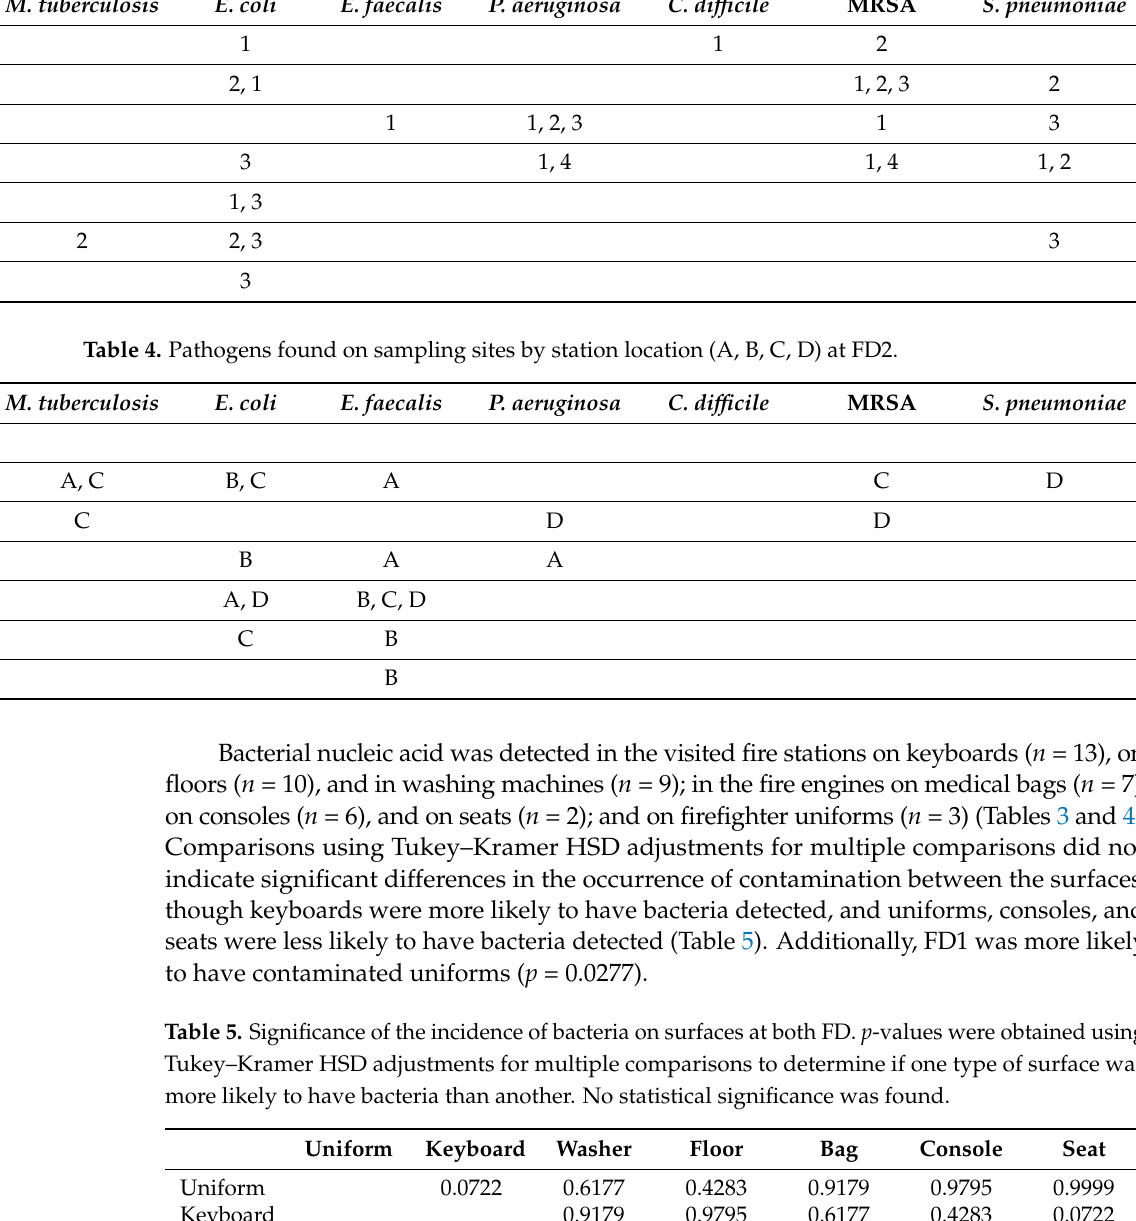
Table 3. Pathogens found on sampling sites by week of collection (1, 2, 3, 4) at FD1. M. tuberculosis